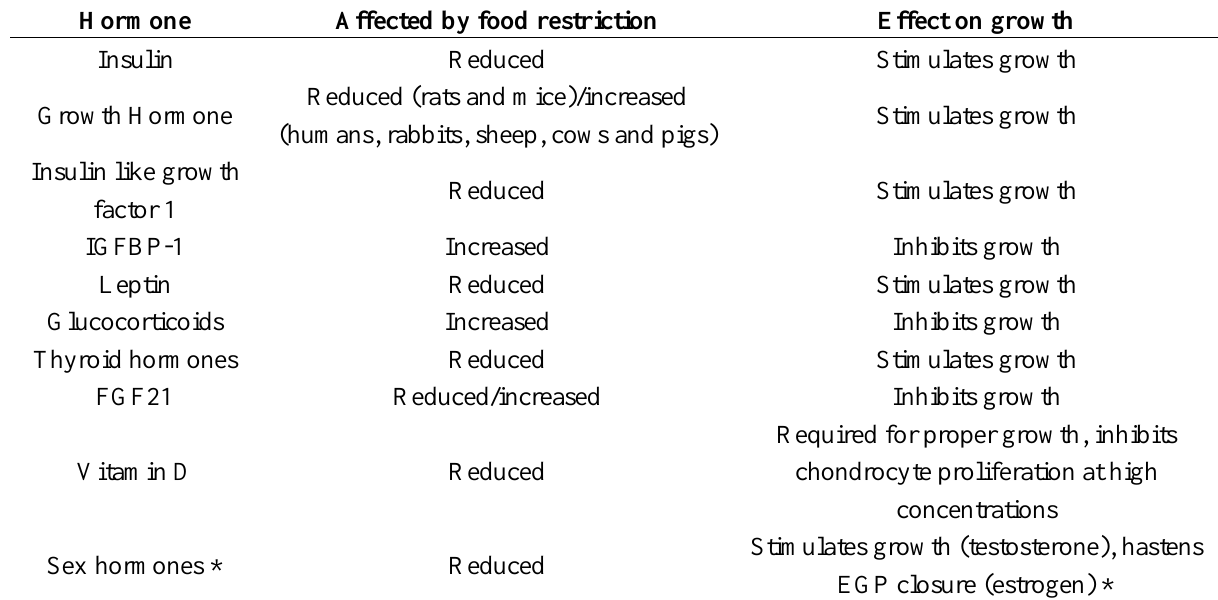
Table 1. Hormones and growth factors that are specifically affected by the nutritional